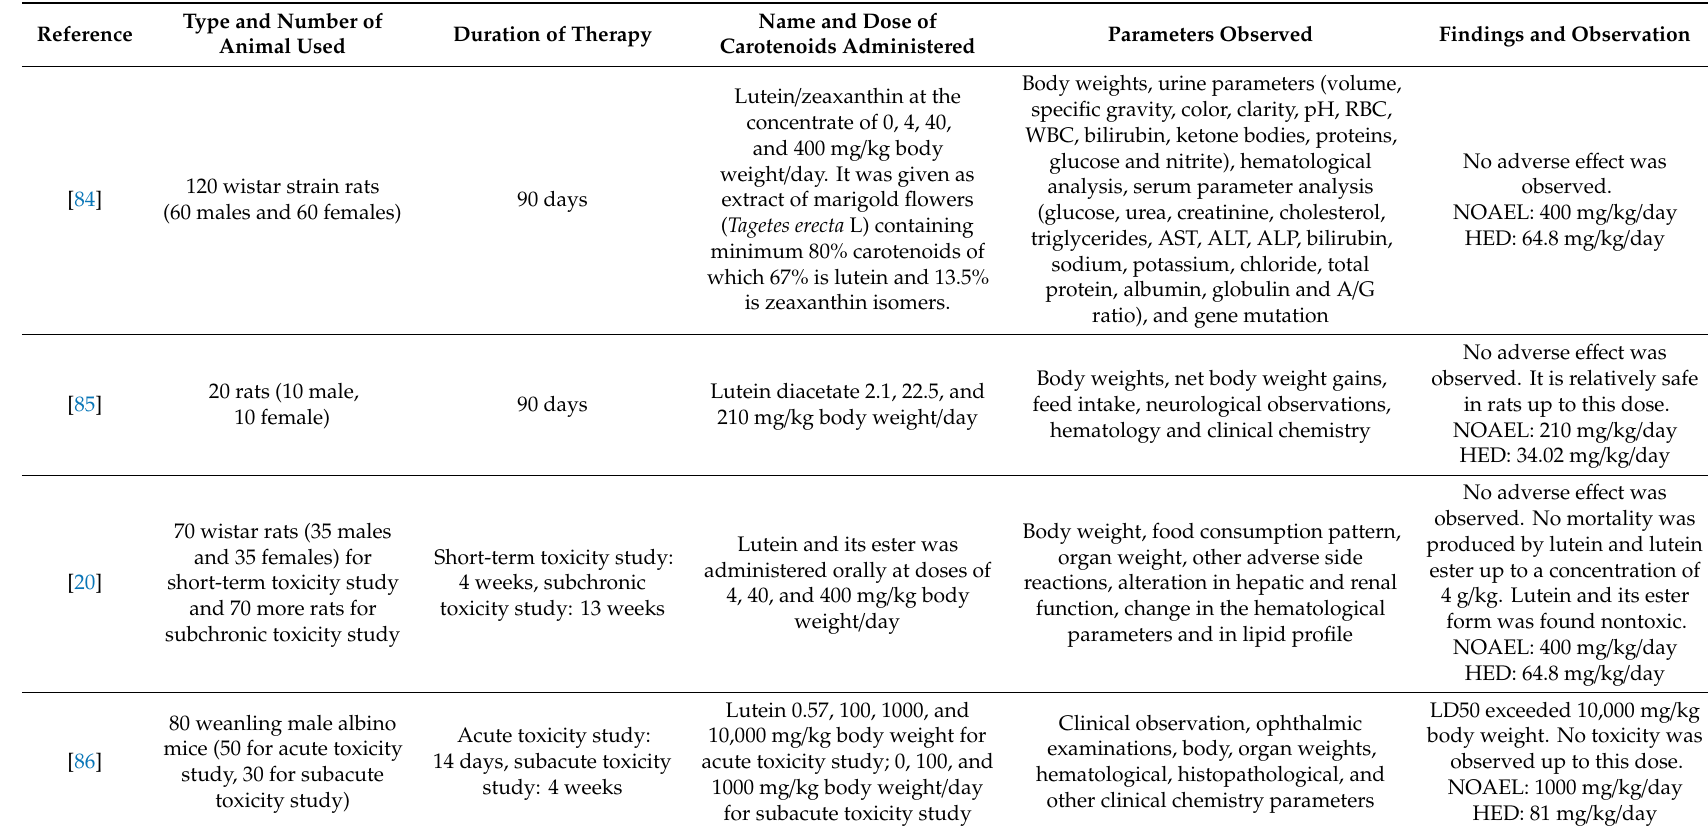
Table 1. In vivo preclinical studies to assess the safety of